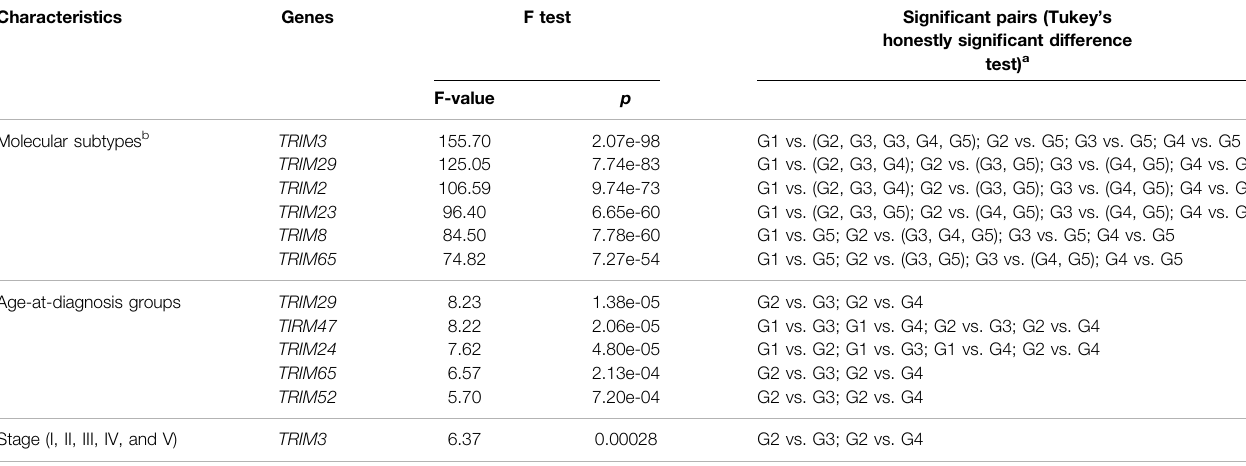
TABLE 2 | Association of TRIMs ’ expression and breast cancer clinical